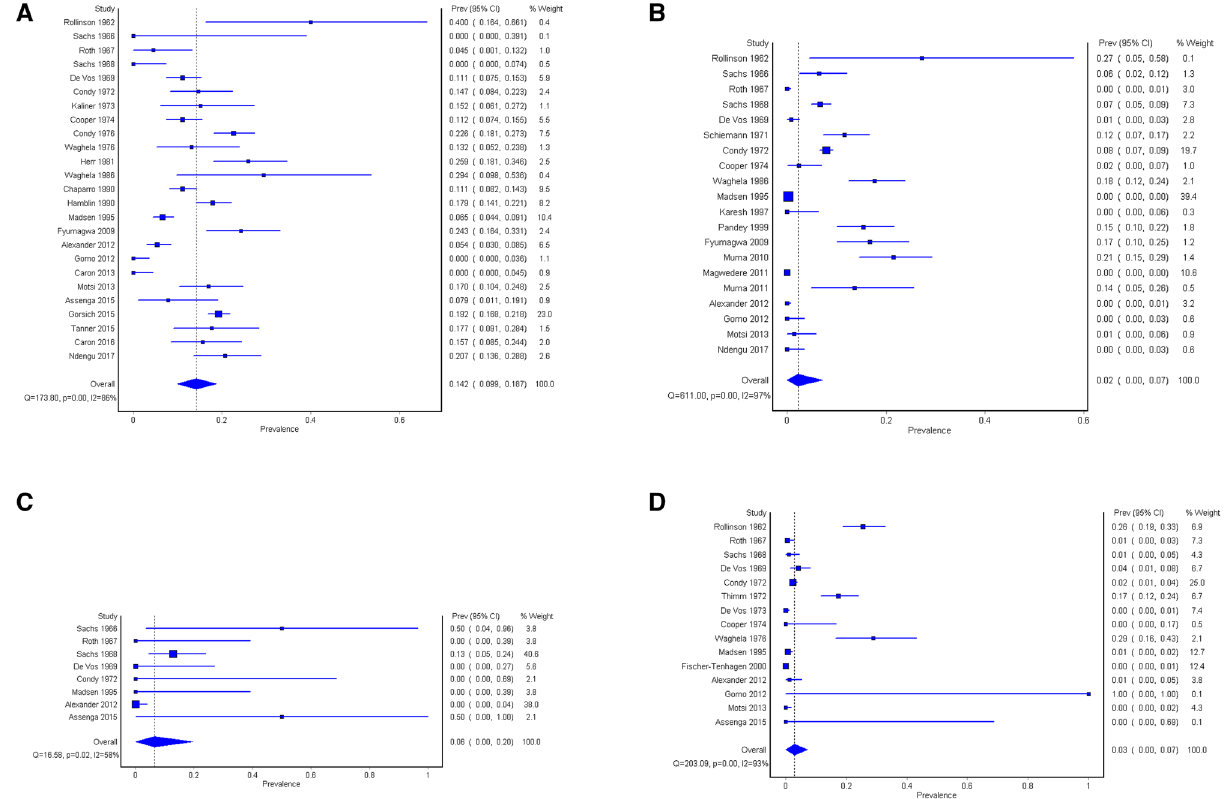
Figure 2. ( a ) African buffalo. ( b ) African wild antelope species. ( c ) African wild carnivore species. ( d ) African wildlife species excluding buffalo, antelope and carnivores. Forest plots of Brucella seroprevalence in: ( a ) African buffalo (n = 25 studies), ( b ) African wild antelope species (n = 20 studies), ( c ) African wild carnivore species (n = 8 studies) and ( d ) African wildlife excluding buffalo, antelope and carnivores (n = 15 studies), aggregated by publication, with weight contribution to pooled prevalence estimate (proportional to the inverse variance of each study’s prevalence estimate). Studies are shown chronologically from top to bottom. Blue squares show point estimates, with size of square proportional to sample size; horizontal lines indicate 95% confidence intervals; diamond shows point estimate and 95% confidence interval for pooled estimate. I2 is the heterogeneity (Higgins’ I 2 ), indicating the proportion of variability between study results attributed to heterogeneity. Q is the Cochran’s statistic used to test the null hypothesis that I 2 =